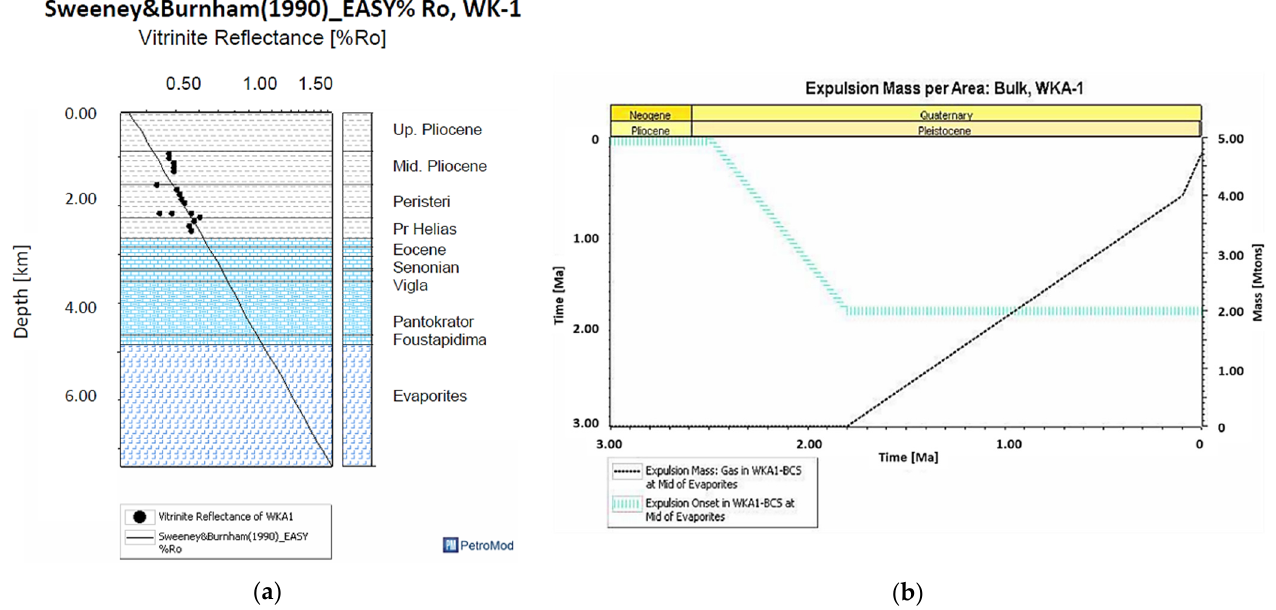
Figure 3. ( a ) Final maturity calibration fit of the WK-1 model, based on Vitrinite Reflectance (%Ro) data (unpublished data from Energean S.A). ( b ) Expulsion Mass and Onset of the Triassic evaporites of the WK-1 model.